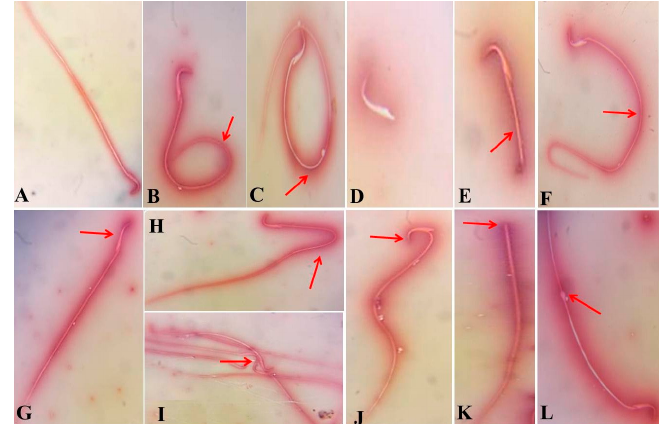
Figure 1. Photomicrographs of semen smears of the control, vehicle control, Vit-C, and BOL + Vit-C treated rats showing sperms with normal morphology ( A ). Photomicrographs of eosin–nigrosin-stained semen smears of boldenone (BOL) and / or vitamin C (Vit-C) exposed rats for eight weeks showing di ff erent forms of epididymis sperm abnormalities in BOL tread rats, including coiled tail ( B ), looped tail ( C ), detached tail ( D ), short tail ( E ), curved tail ( F ), less hock head ( G ), Bent tail ( H ), Fused sperm ( I ), broken head ( J ), detached head ( K ), and protoplasmic droplet ( L ) (100 × ).